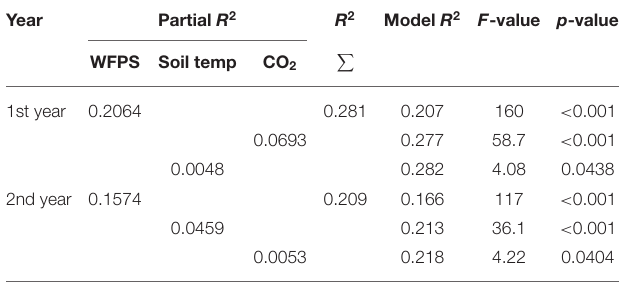
TABLE 3 | Output of (stepwise forward) regression analysis for N 2 O fluxes in the 1st and 2nd year, testing for the inclusion of parameters CO 2 flux, water filled pore space (WFPS), and soil temperature into the model (model